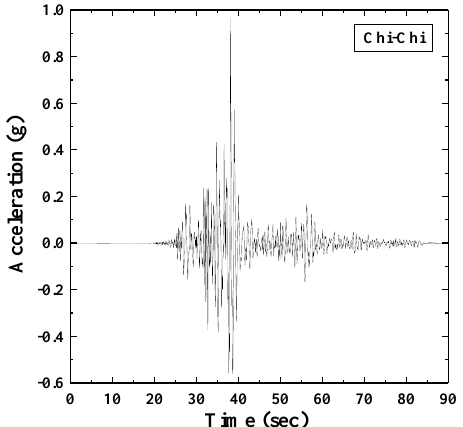
Fig. 3. History of ground acceleration record during the 21 September 1999 Chi-Chi (M w = 7.6) earthquake (COSMOS, 2010)